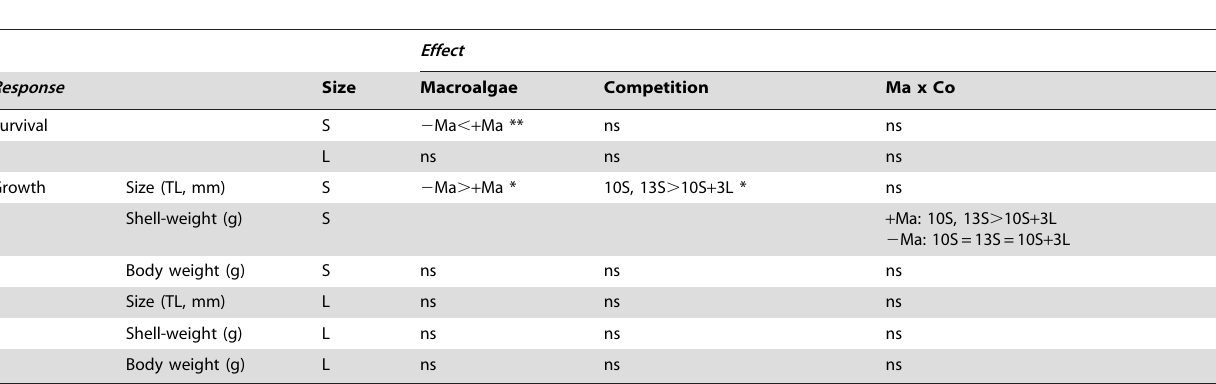
Table 4. Summary of the effects of macroalgae (Ma) and competition (Co) on small (S, 15 mm) and large (L, 30 mm) limpets.*